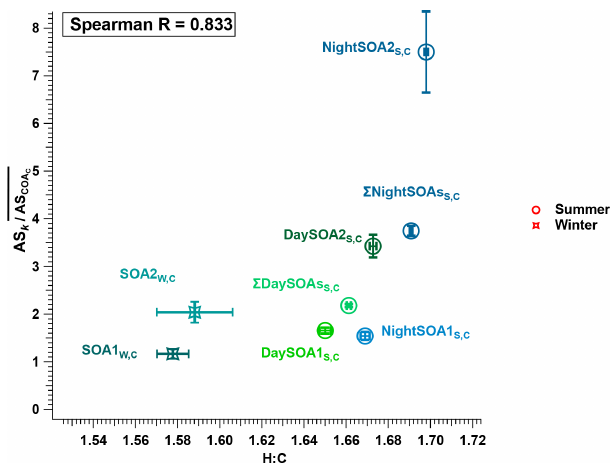
Figure 7. AS k / AS COA of SOA factors retrieved from the summer C and winter datasets as a function of the H : C ratio. Error bars denote standard deviation across all accepted runs. Spearman correlation is 0.833, as indicated in the top-left corner.